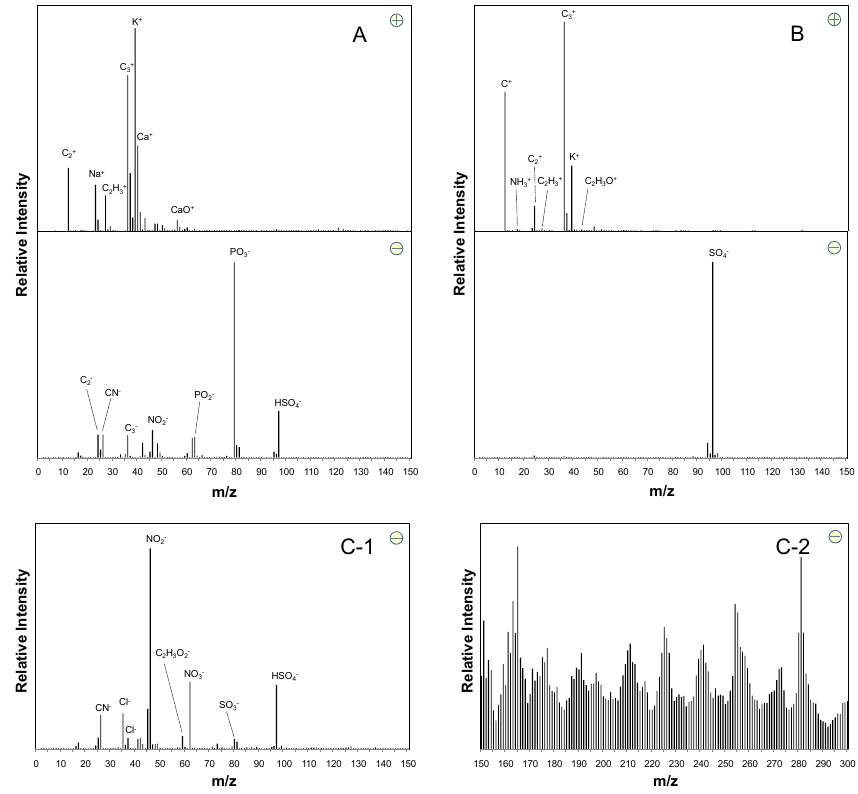
Fig. 13. Average dual ion mass spectra of ATOFMS particle classes; (A) EC-oil, (B) ECOC, and average negative ion mass spectra for (C-1) Oligomer ( m/z 0–150) and (C-2) Oligomer ( m/z 150–300).